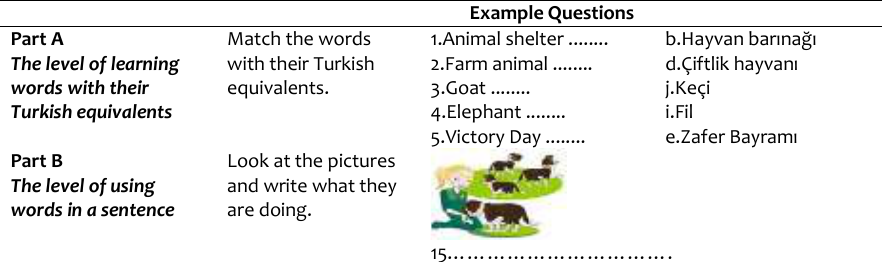
Table 5. Example questions for each part of the Achievement